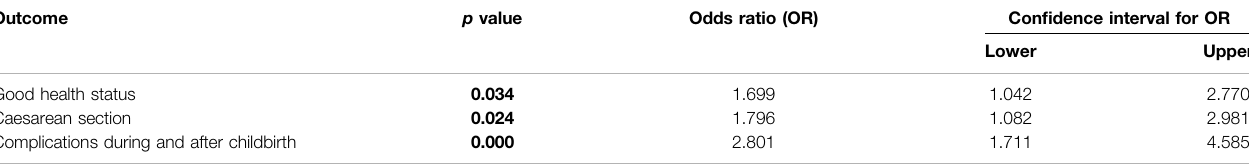
TABLE 5 | Logistic regression model showing herbal medicine use predicting the outcome of pregnancy. Outcome